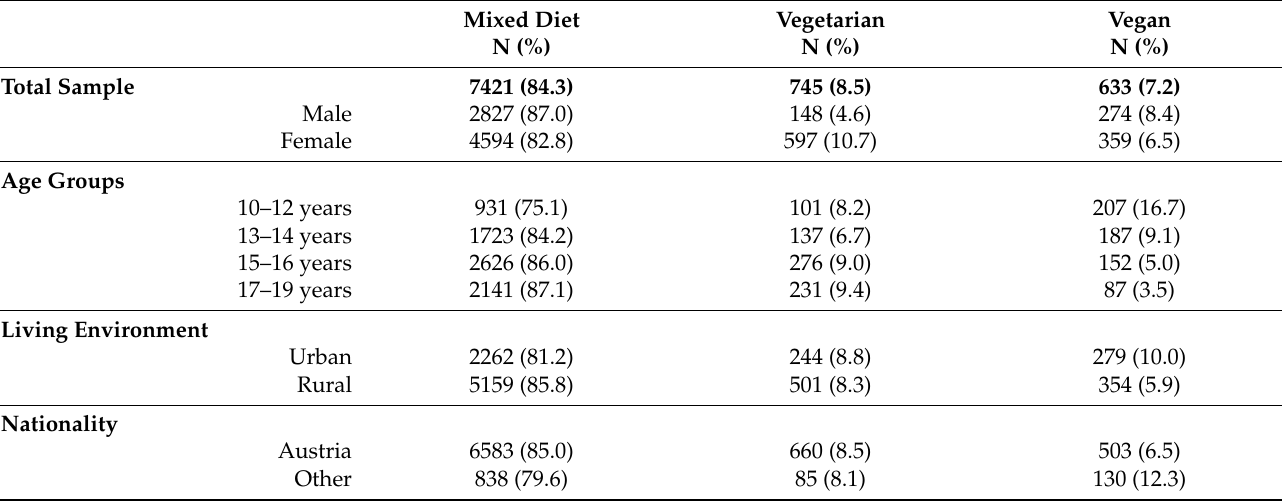
Table 5. Dietary pattern by sex, age, living environment, and nationality. Values are the number of participants (N) and prevalence (%).